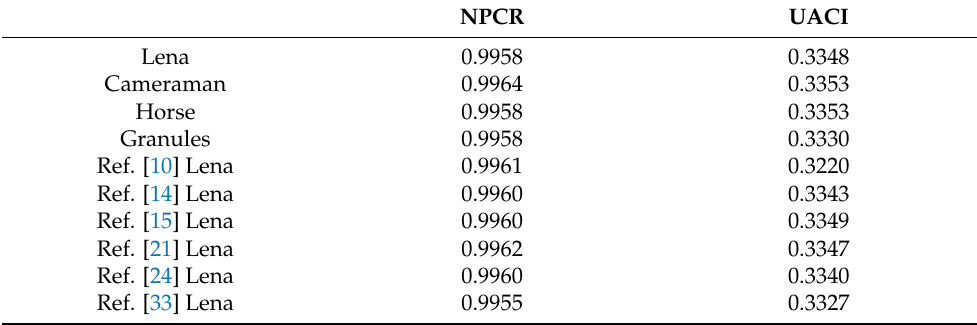
Table 4. NPCR and UACI